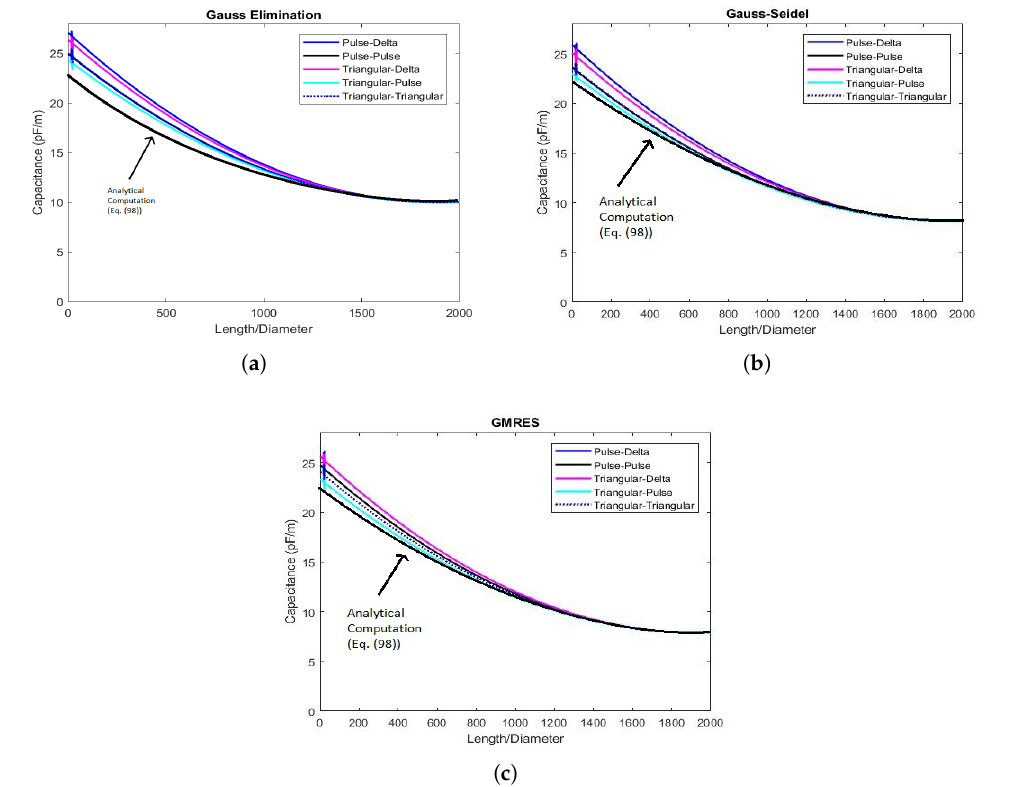
Figure 3. C vs. L / d ratio for each basis-testing functions with the ( a ) Gauss elimination procedure, ( b ) Gauss–Seidel method and ( c ) GMRS algorithm.